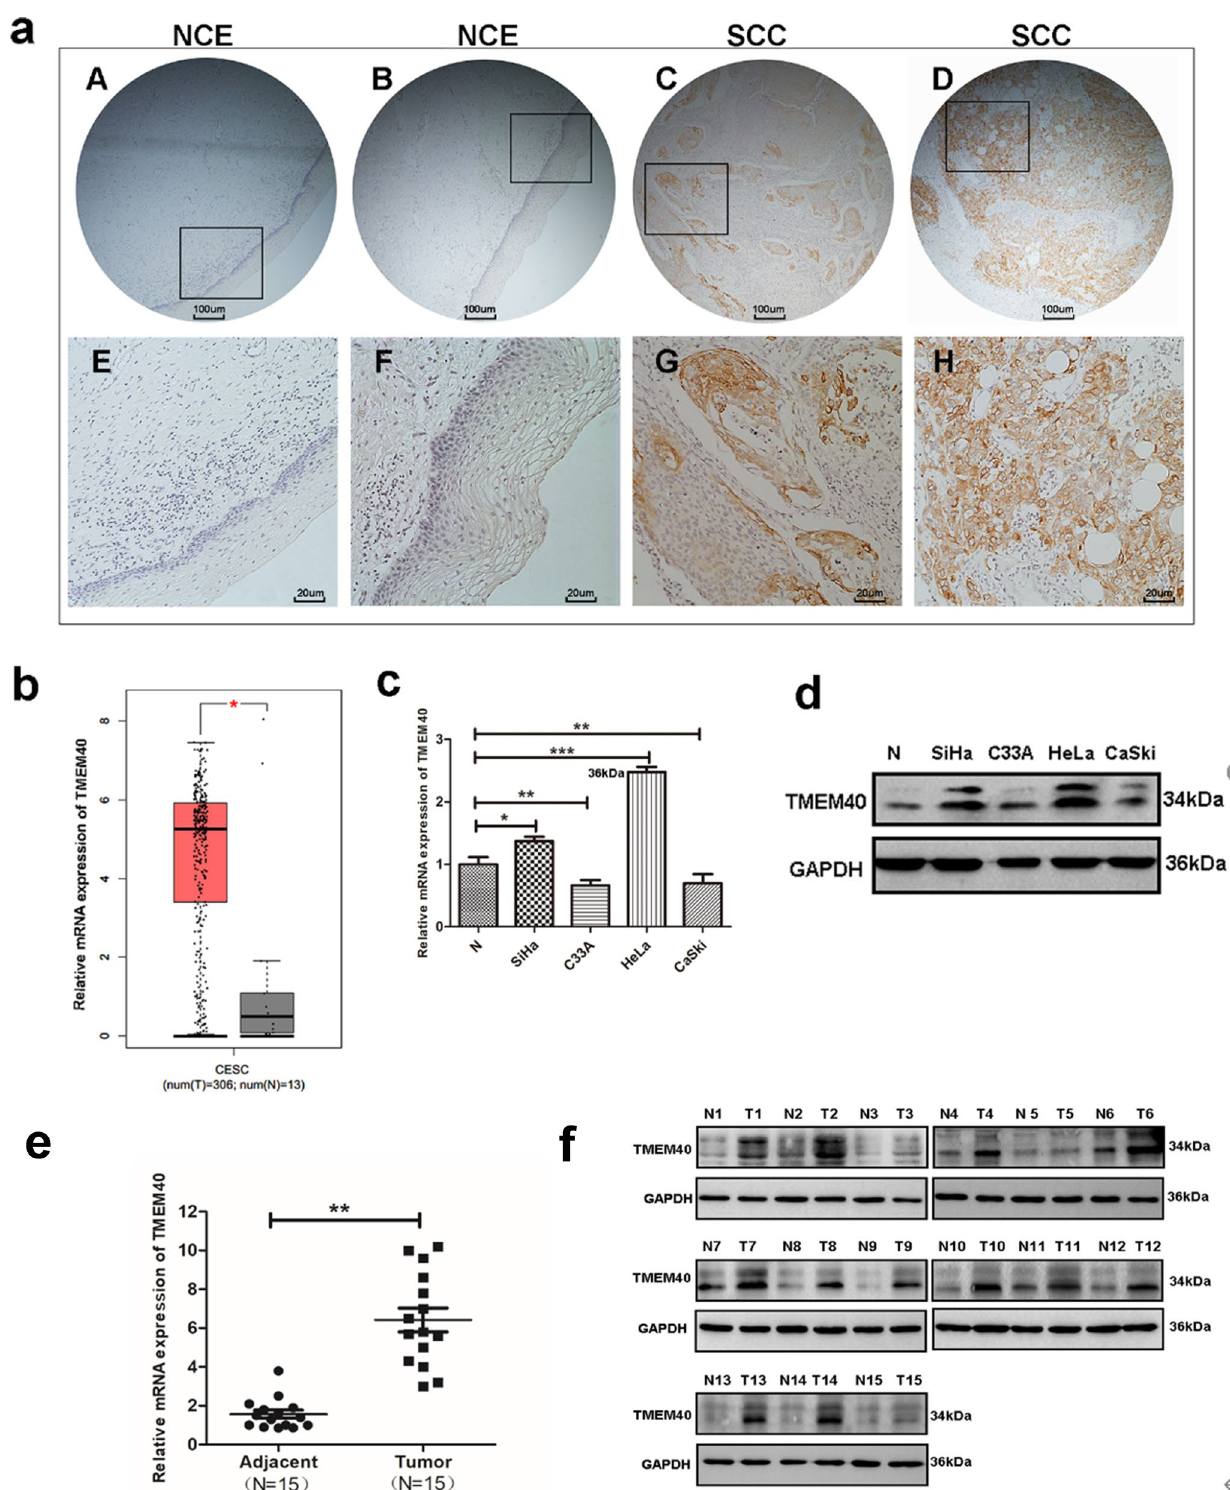
Fig. 1 TMEM40 expression level is significantly upregulated in cervical cancer tissues and cell lines. a , Representative immunohistochemical staining of TMEM40 protein in normal cervical epithelium (NCE) and cervical squamous cell carcinoma (SCC) with different staining intensities (A–D, 40 × ; E–H, 200 ×). Lower panels (200 ×) were high magnification of squared areas in upper panels (40 ×). b , Quantification of TMEM40 mRNA expression in CC and normal tis- sues. TMEM40 expression was significantly increased in CC tissues (n = 306) compared with normal tissues from the patients (n = 13) from the GEPIA data- set. c and d , qRT-PCR and western blot analysis of TMEM40 mRNA and protein expression in CC cell lines (C33A, HeLa, SiHa and CaSki) and normal cervical epithelium (N). e and f , Expression level of TMEM40 in tissues was detected by qRT-PCR and western blot. * P < 0.05, ** P < 0.01, *** P <